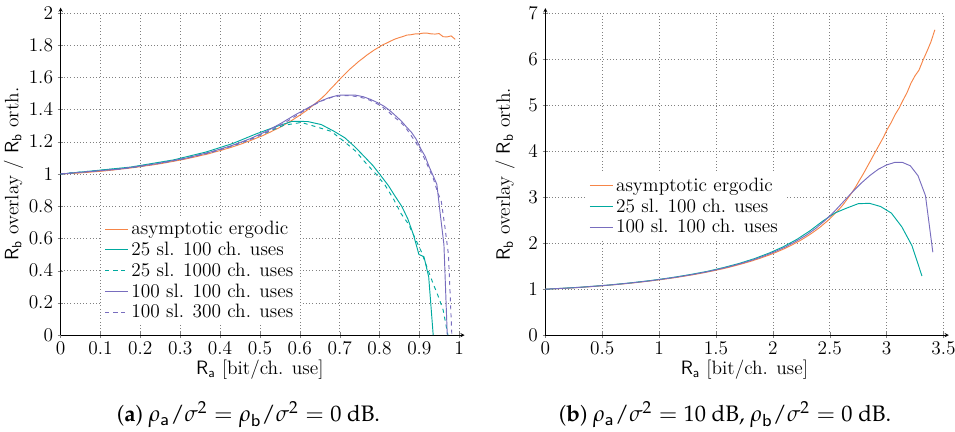
Figure 5. Ratio of the maximum rate achievable by service S b with an overlay allocation ( R b overlay) over the one with an orthogonal allocation ( R b orth.) as a function of R a . Both the ergodic asymptotic setting and the finite length scenarios are presented. In the latter, we set the target average codeword error probability of service S a to 10 − 3 for both SNR setups. M = 25 and M = 100 slots together with n s = 100 and n s = 300 channel uses are investigated for ρ a / σ 2 = ρ b / σ 2 = 0 dB, while only n s = 100 channel uses for ρ a / σ 2 = 10 dB, ρ b / σ 2 = 0 dB are